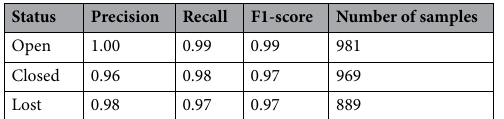
Table 1. Metrics for evaluating the status classification on the hold-out test set.